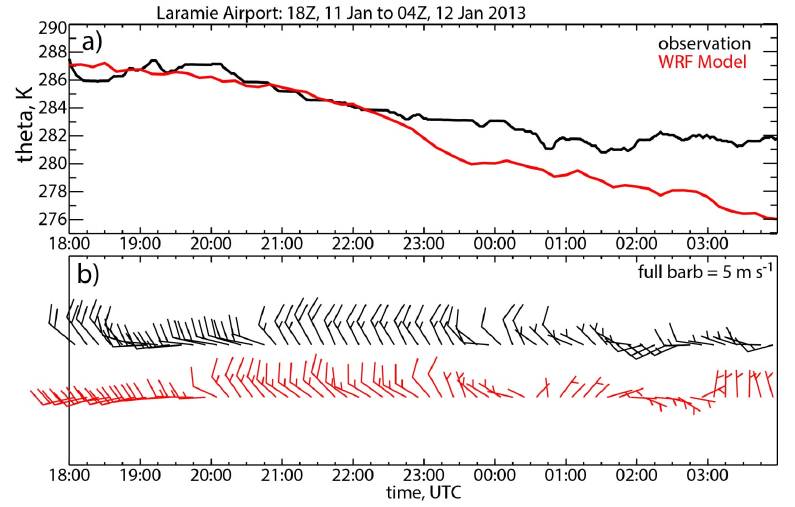
Figure 4. Comparison of surface observations ( black ) against WRF model ( red ) for ( a ) potential temperature and ( b ) wind. The model is compared against observations from the Laramie Regional Airport weather station during a 10-hour period on 11–12 January 2013.